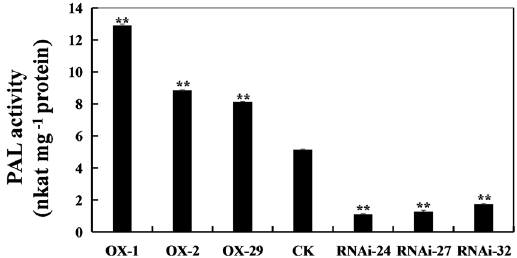
Figure 6. PAL activity in non-transgenic and transgenic soybean leaves treated with P . sojae inoculum at 36 h. The non-transgenic soybean plants were used as controls. The experiment was performed on three biological replicates with their respective three technical replicates and statistically analyzed using Student’s t-test ( * P < 0.05, ** P < 0.01). Bars indicate the standard error of the